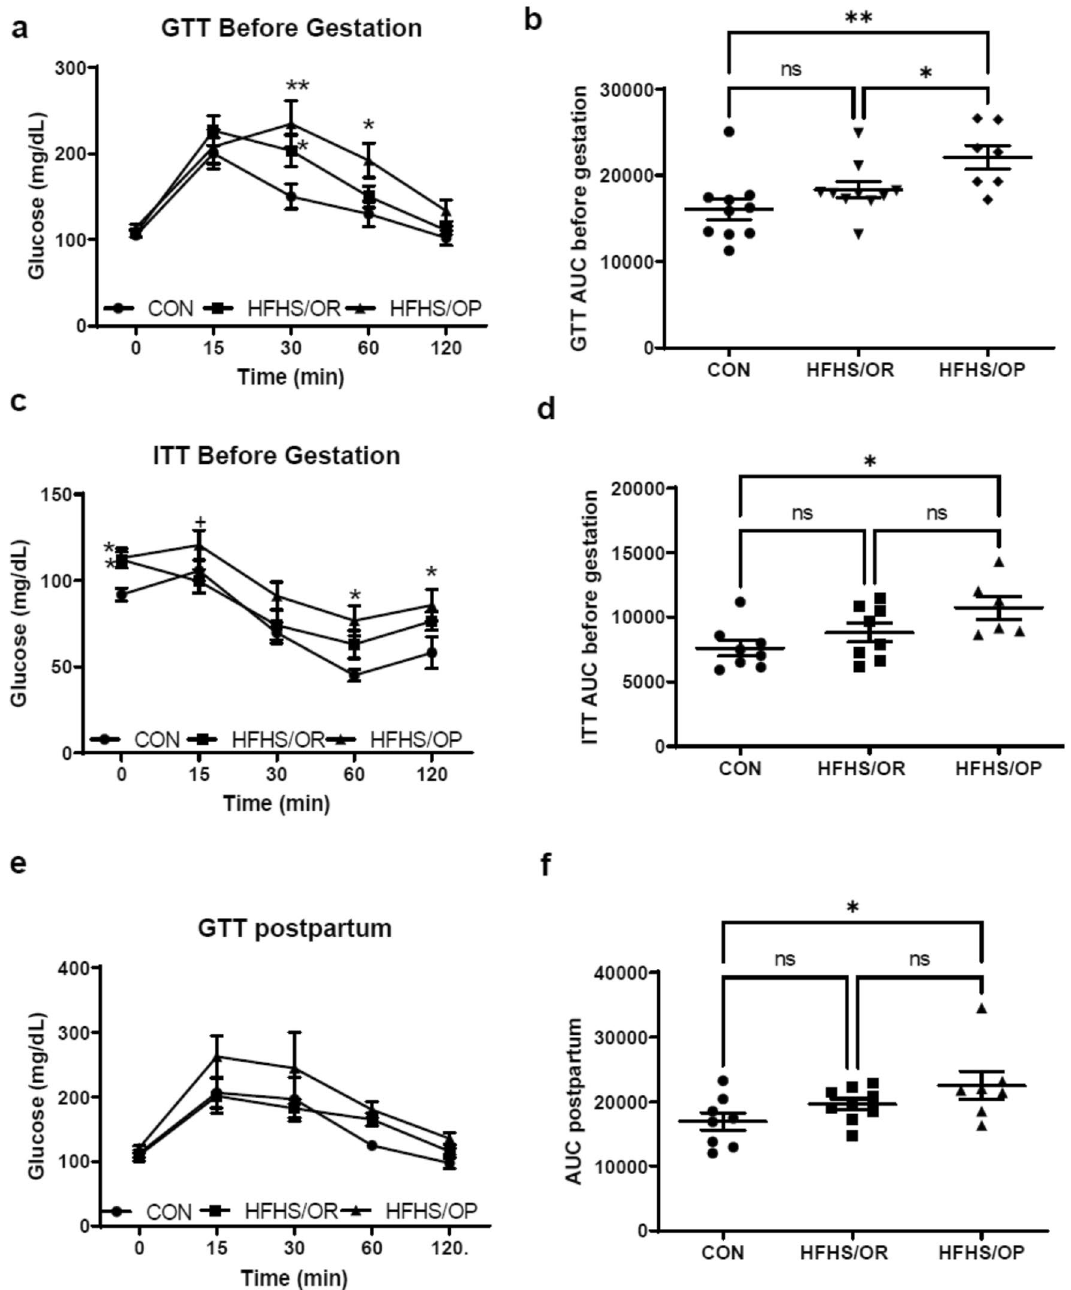
Figure 2. Glucose and insulin tolerance tests. GTT and ITT measurements at 0, 15, 30, 60, and 120 min after glucose ( a and e ) and insulin injection ( c ). ( a ) The HFHS/OP group had significantly impaired glucose clearance and insulin-stimulated glucose clearance compared to the CON group. The area under the curve (AUC) of GTT ( b ) and ITT ( d ). Impaired glucose clearance ( e and f ) was persistent at 6 weeks of postpartum. CON, control diet indicated by closed circles (filled circle); HFHS/OR, obese-resistant mice fed with a high-fat and a high- sucrose diet indicated by closed squares (filled square); HFHS/OP, obese prone mice fed a high-fat high-sucrose diet indicated by a closed triangle (filled triangle). An individual dot indicates the sample size; n = 6–10/group. Values are presented as mean ± SEM. Statistical significance is calculated by two-way ANOVA followed by Tukey’s multiple comparisons ( a , c , and e ) or one-way ANOVA ( b , e , and f ).* p < 0.05, versus CON; + p < 0.05, versus HFHS/OR; ** p < 0.001, versus